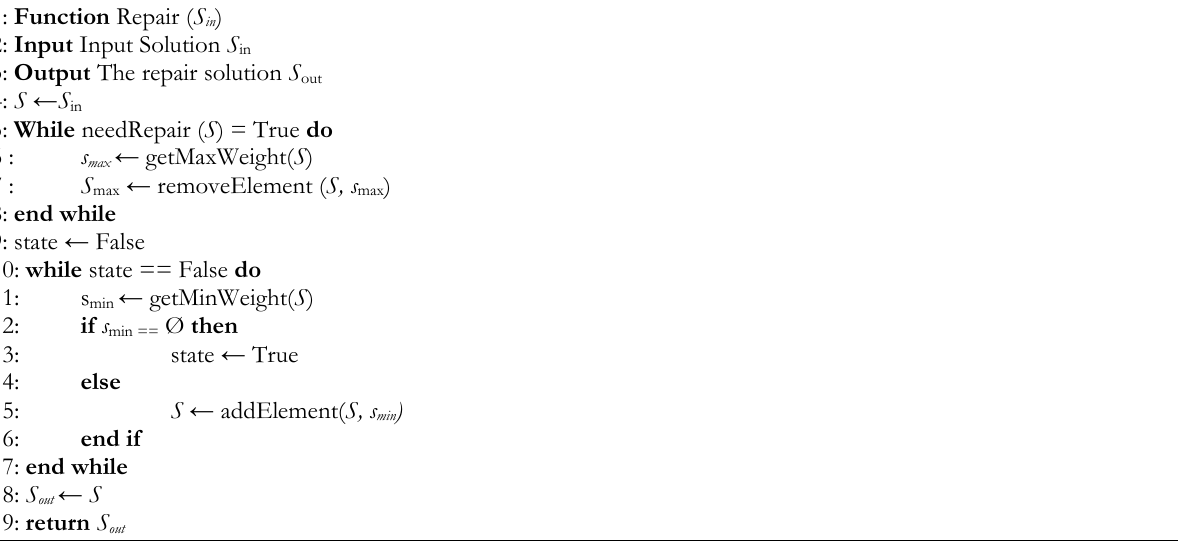
Algorithm 2. Repair Algorithm